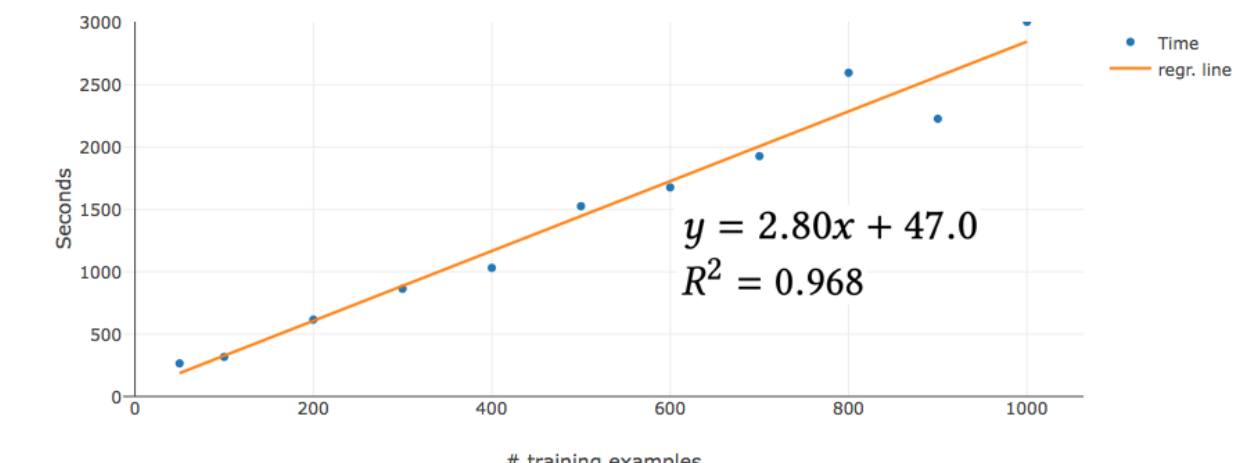
Figure 15. Time for hyper-parameter optimization. The formula of the regression line is y = 2.80 x + 47.0, and the determi- nation coefficient is R 2 = 0.968.